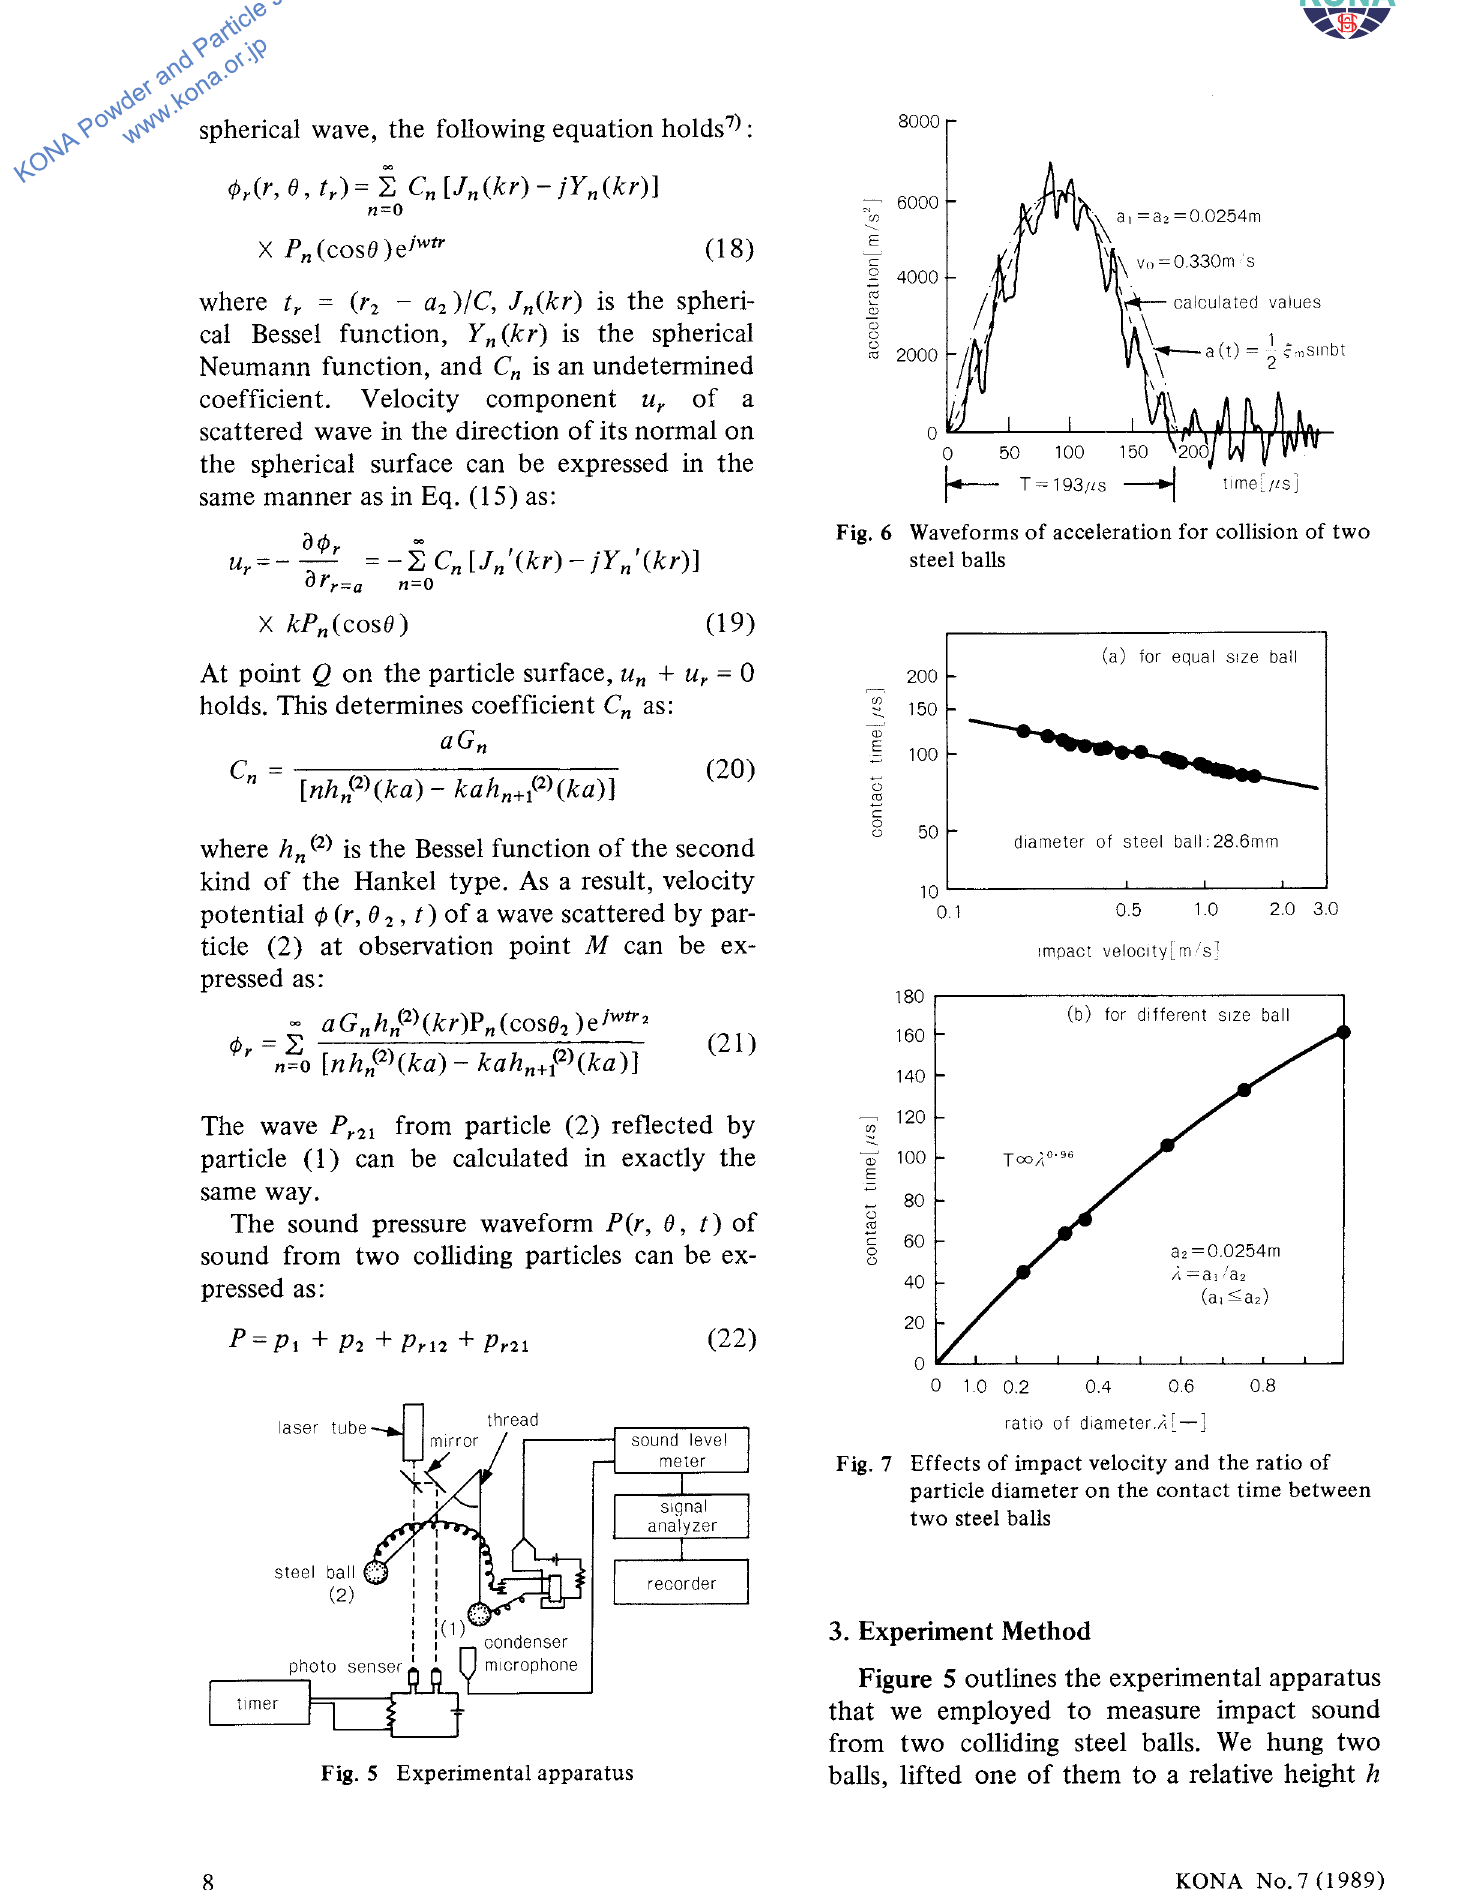
Fig. 5 Experimental apparatus